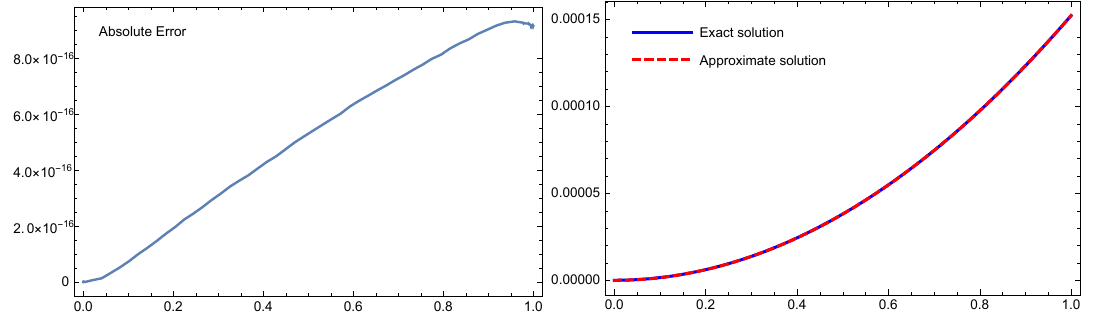
Figure 6. For Example 3, Case III with m = 6: the absolute error is shown on the ( left ), and the analytic and an approximation solutions are presented on the ( right ).